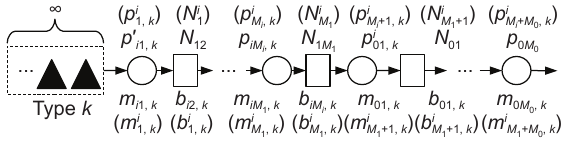
Fig. 5 Auxiliary serial lines.